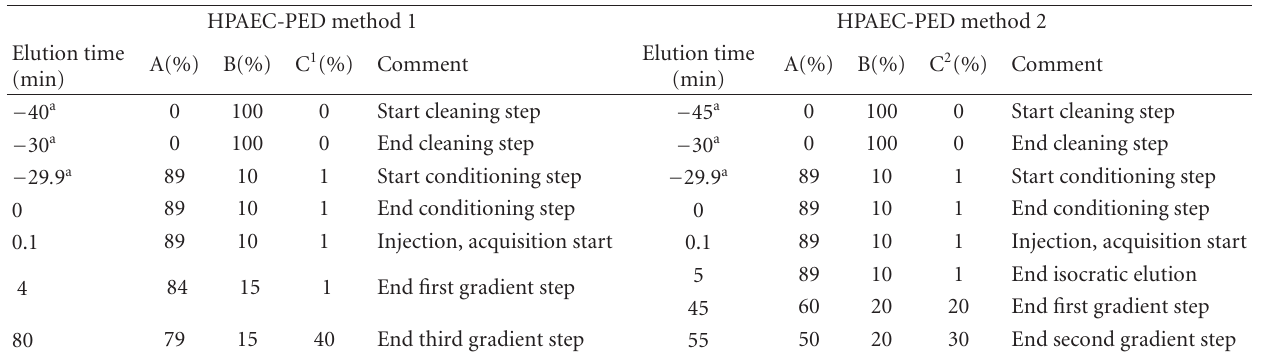
Table 1: Gradient elution program to elute (method 1) FOS and inulin and (method 2) scFOS. HPAEC-PED method 1